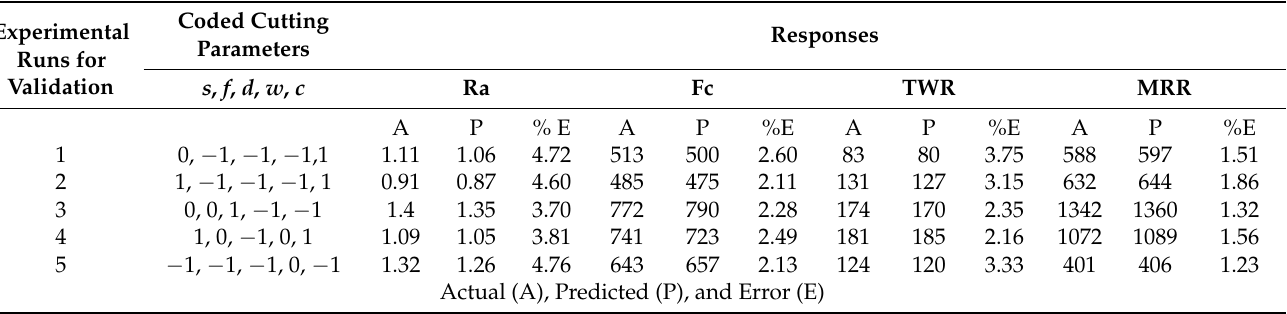
Table 13. Validation tests of prediction model.